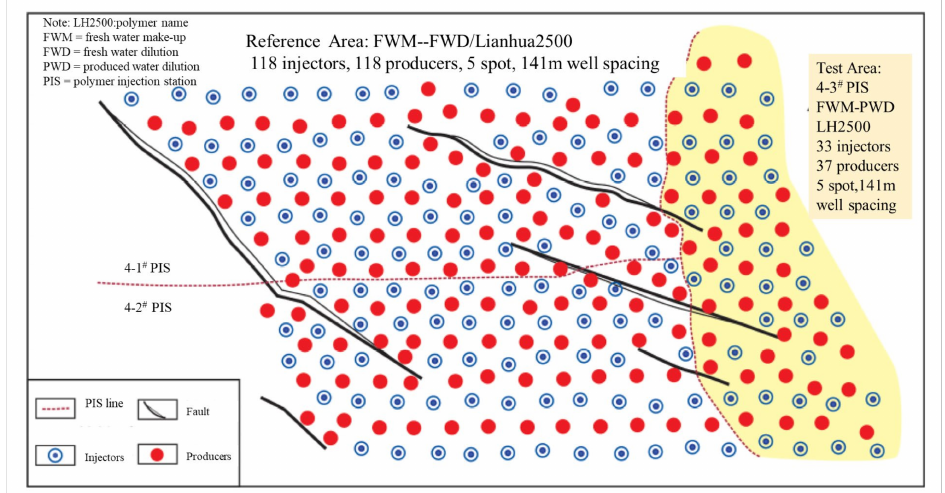
Figure 14. Polymer-flooding well pattern of test and reference areas (revised from [134]).